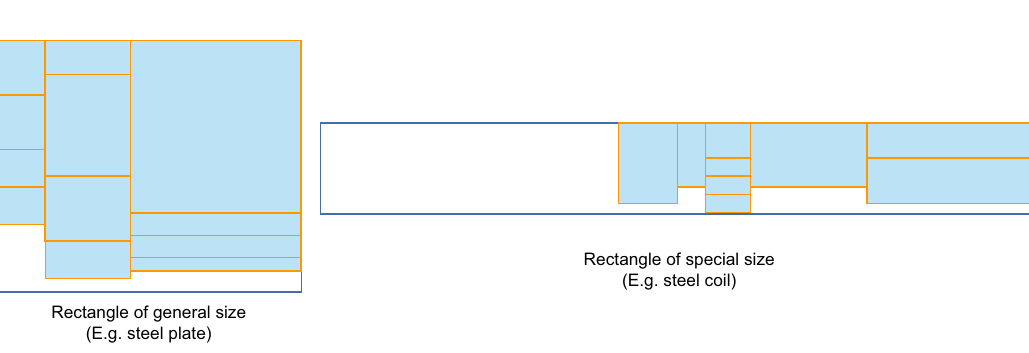
Figure 1. Dense rectangular arrangement (left); rectangular arrangement suitable for sawing machine (right).